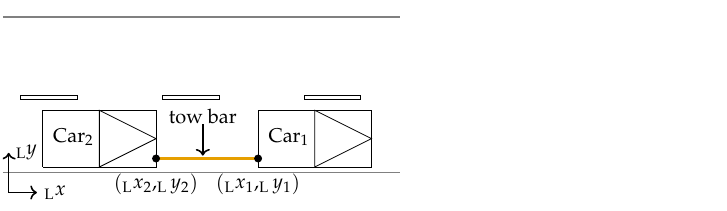
Figure 6. Measurement setup for dynamic dual super-reference with a tow bar in a local coordinate system